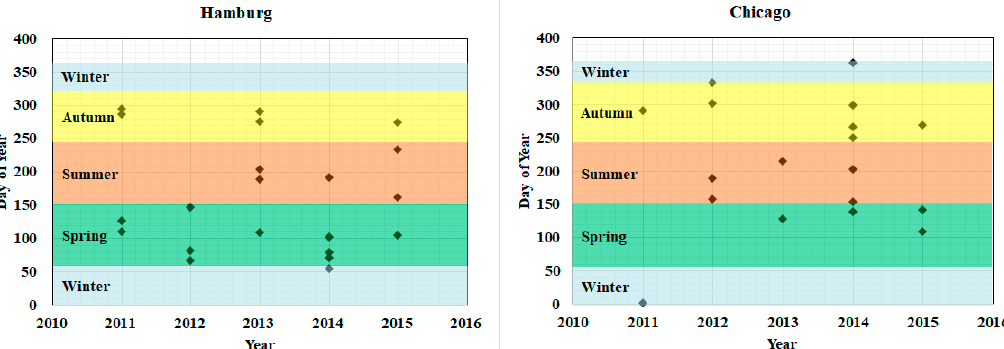
Figure 3. Temporal distribution of the imagery dates of selected Landsat images in the four cities, with each dot denoting one image and each color representing one season.